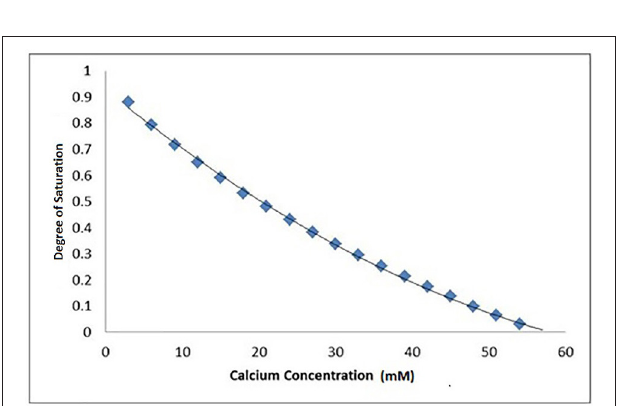
FIGURE 4 | A typical Chemist plot for a pKsp of 118 showing thermodynamic equilibrium is reached at 57mM of calcium at the x-intercept, under pH = 4.0 at 25 ◦ C conditions. The degree of saturation with respect to HAp was calculated based on the conditions and calcium and phosphate concentrations used in the SMR experiment.